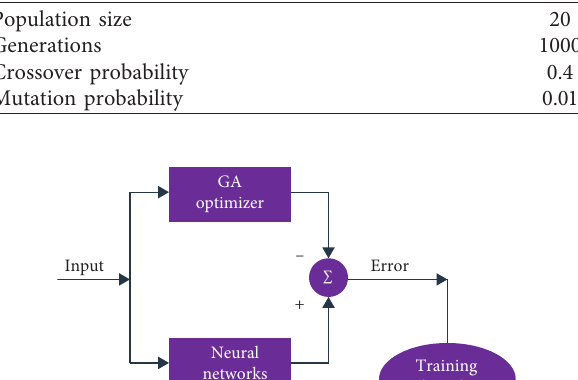
Table 1: Parameters used for the genetic algorithm [16].